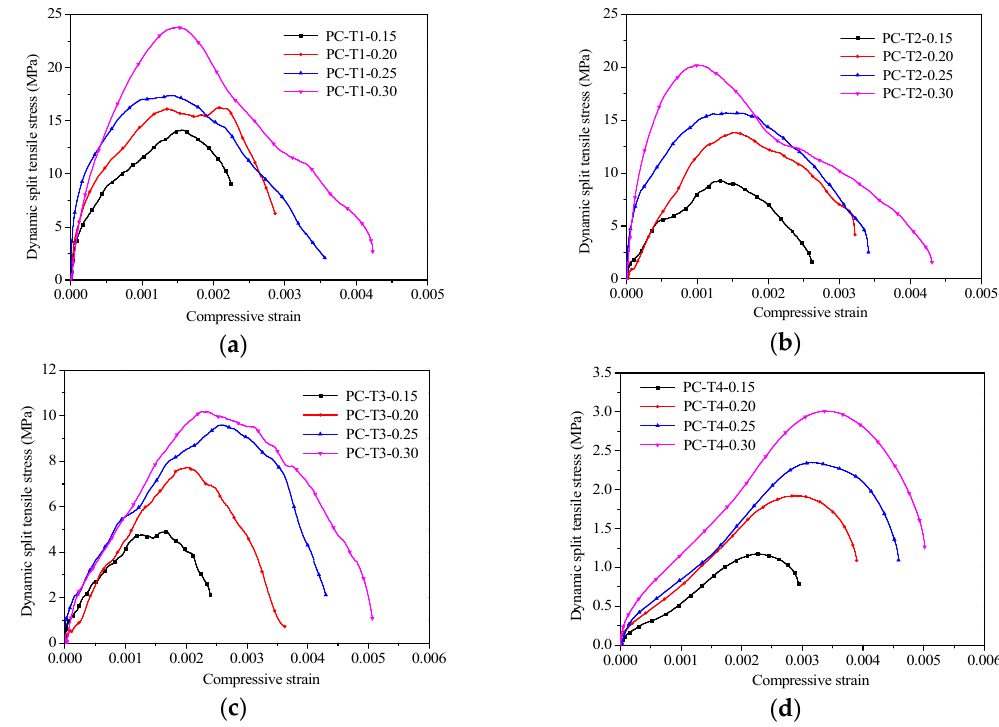
Figure 8. The stress-strain curves of specimens under various impact pressures and temperatures, ( a ) 25 °C, ( b ) 200 °C, ( c ) 400 °C, ( d ) 600 °C.